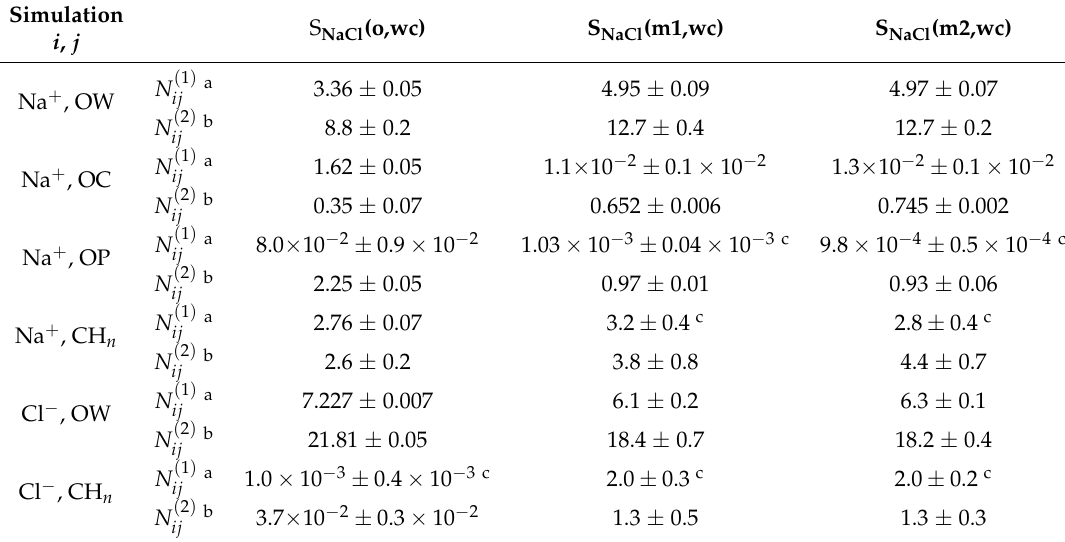
Table 3. Average number of atoms j found in the first ( N Equation (14)) coordination shells of atom i , reported for simulations S NaCl (o,wc), S NaCl (m1,wc) and S NaCl (m2,wc). Atoms i are Na + or Cl − ions, and atoms j are water oxygen atoms (OW), lipid tail carbon atoms (CH n ), lipid ester carbonyl oxygen atoms (OC), or lipid ester phosphate oxygen atoms (OP). The simulation acronyms are explained in Table